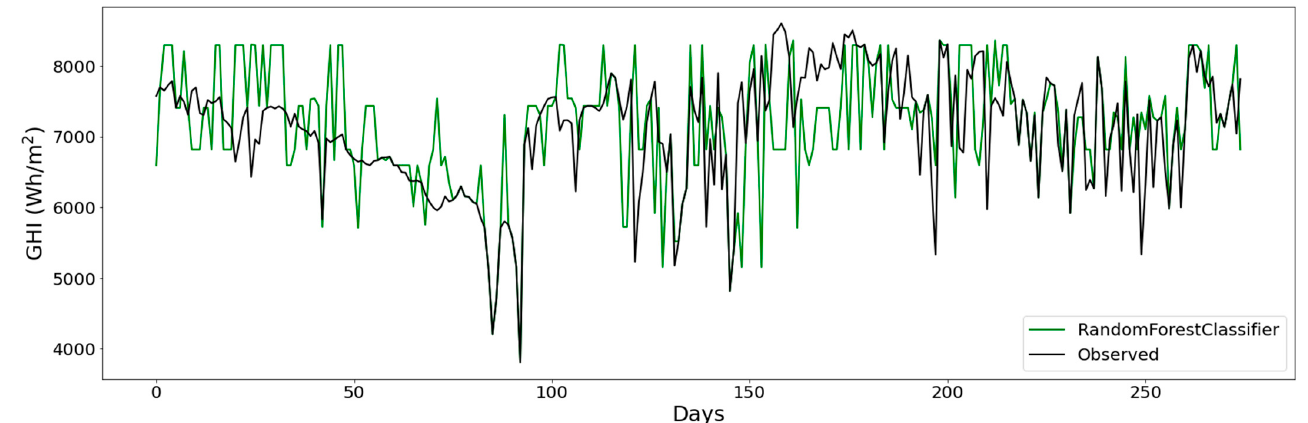
Figure 13. Graphical representation of random forest classifier predictions.